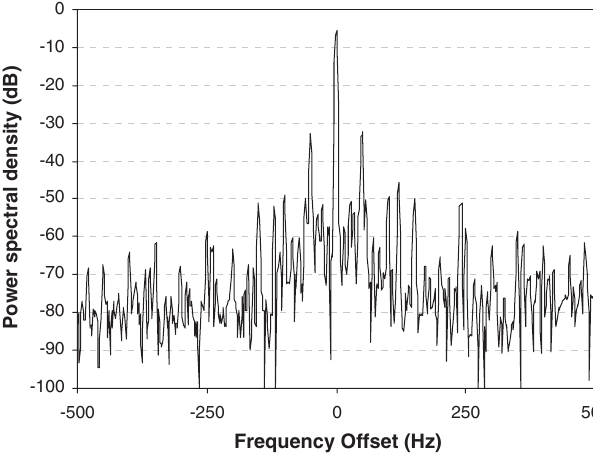
FIG. 9. Cavity spectral output (dB) with shaker for injection locked magnetron with DSP control, RBW ¼ 3 Hz